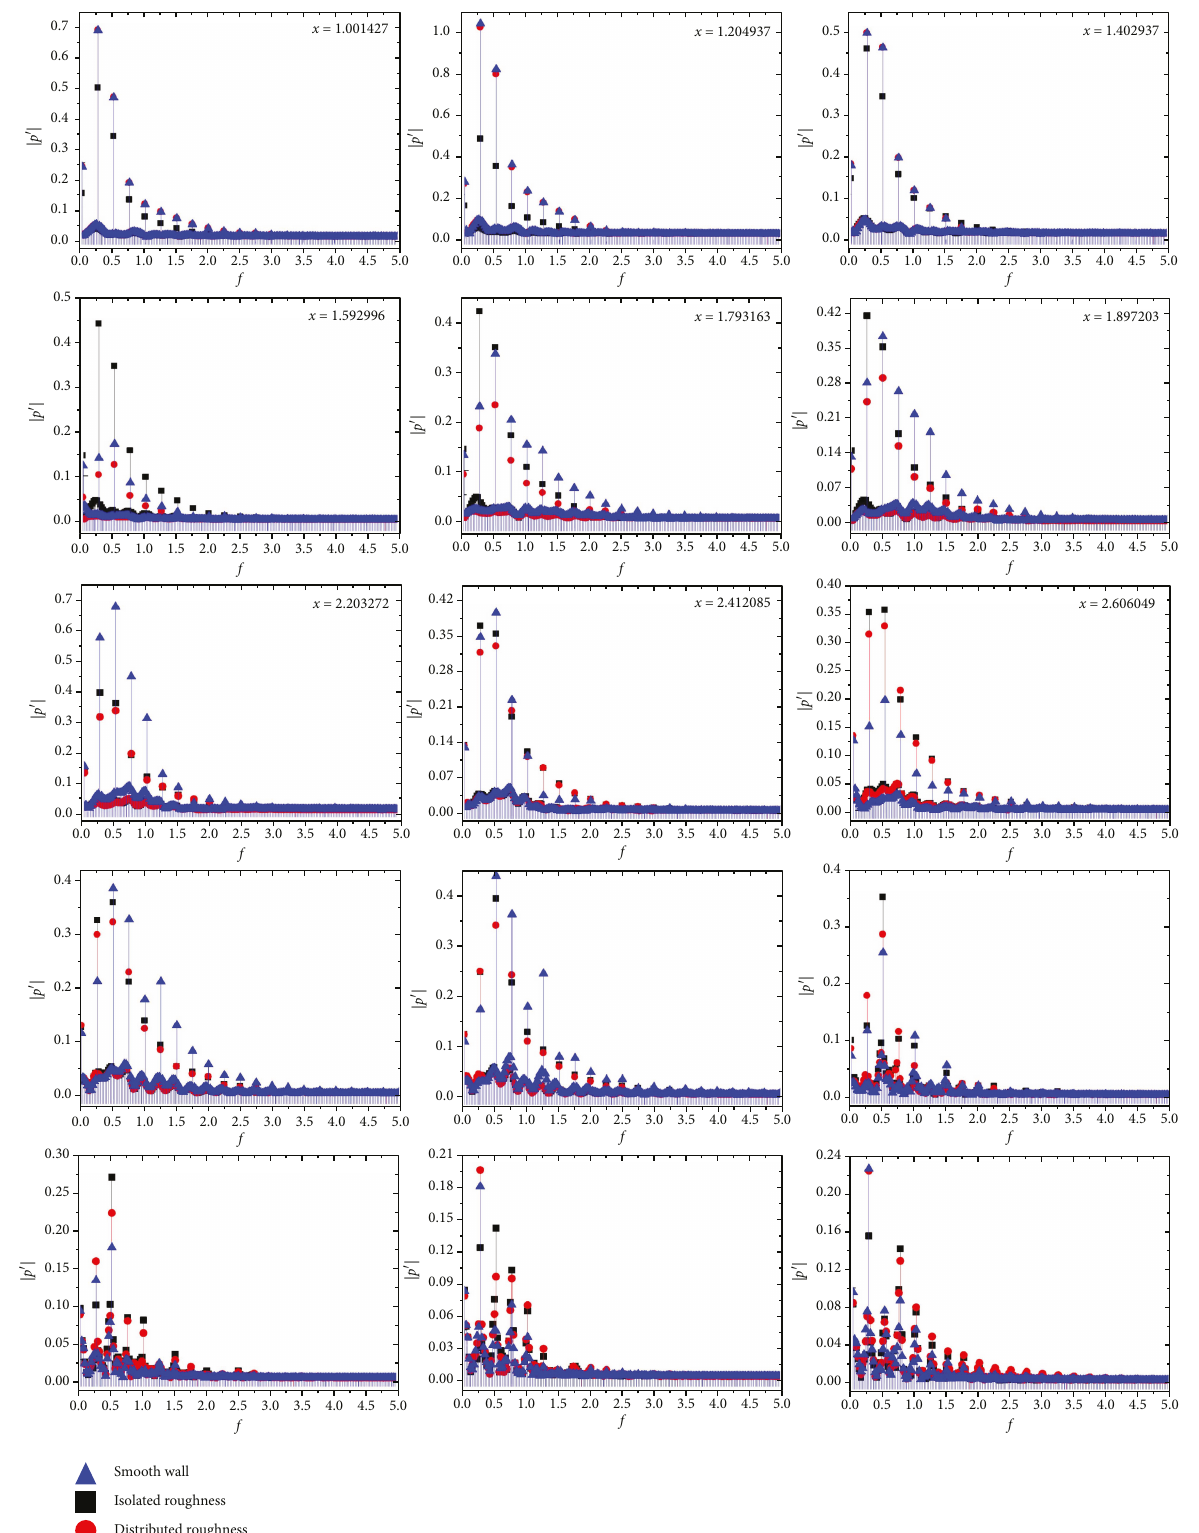
Figure 10: Comparison of Fourier frequency spectral analysis of pressure disturbance in the boundary layer for di ff erent wall